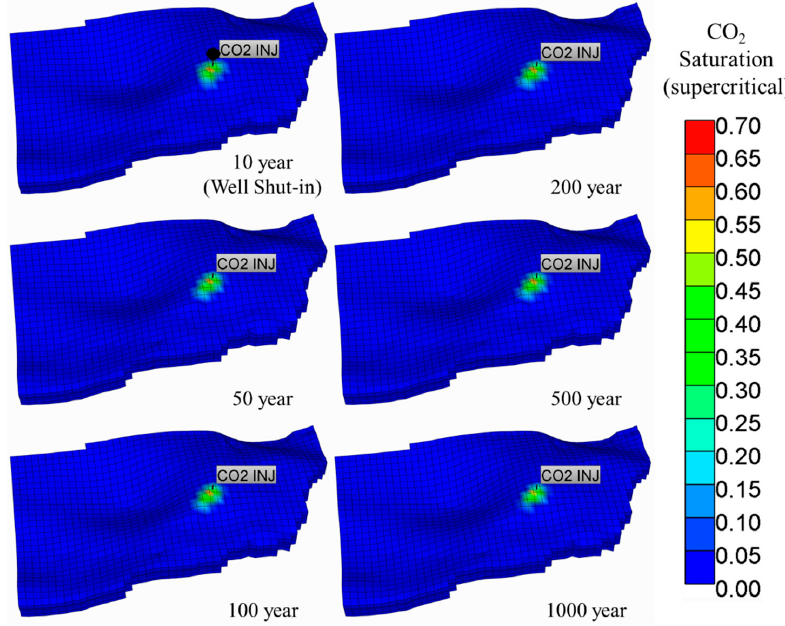
Figure 5. Injection profile of the supercritical CO 2 scenario ( a ) During the injection period, ( b ) During the total simulation period the total simulation period.